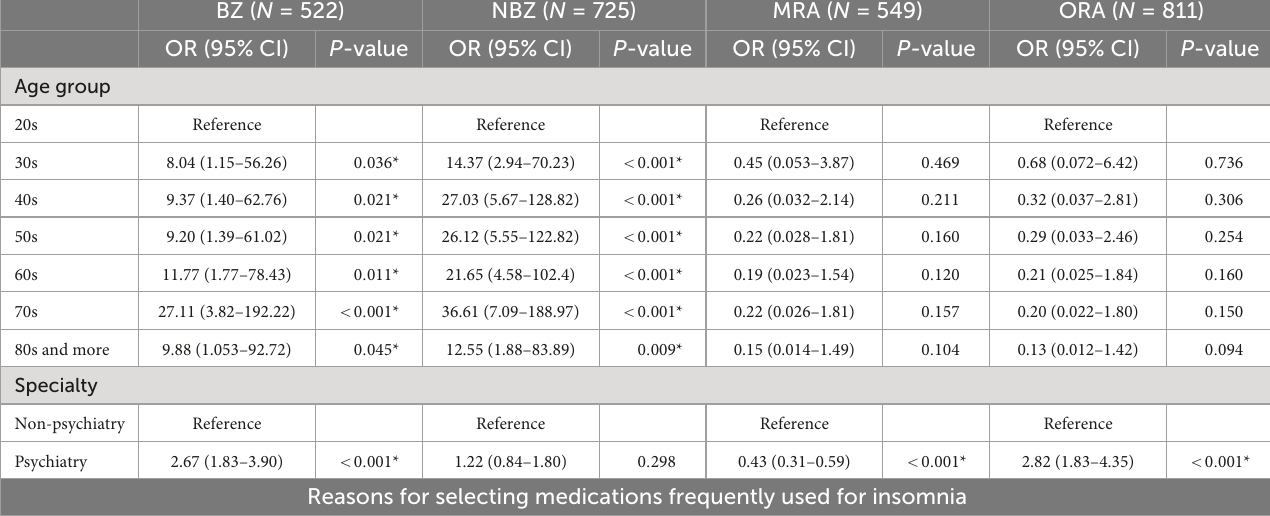
TABLE 2 Logistic regression analysis examining the factors associated with frequent prescribing of each